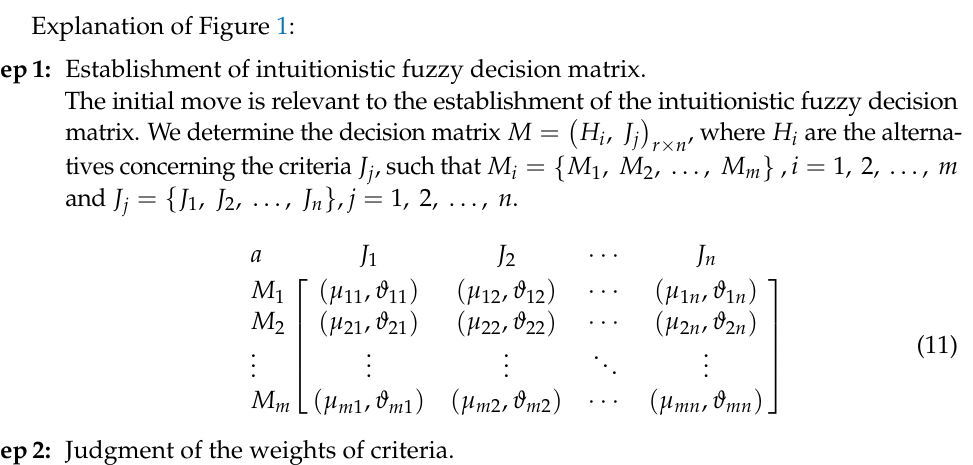
Figure 1. Flowchart of COPRAS